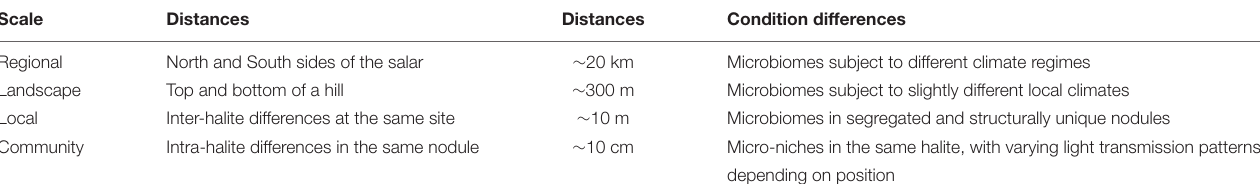
TABLE 1 | Overview of the study